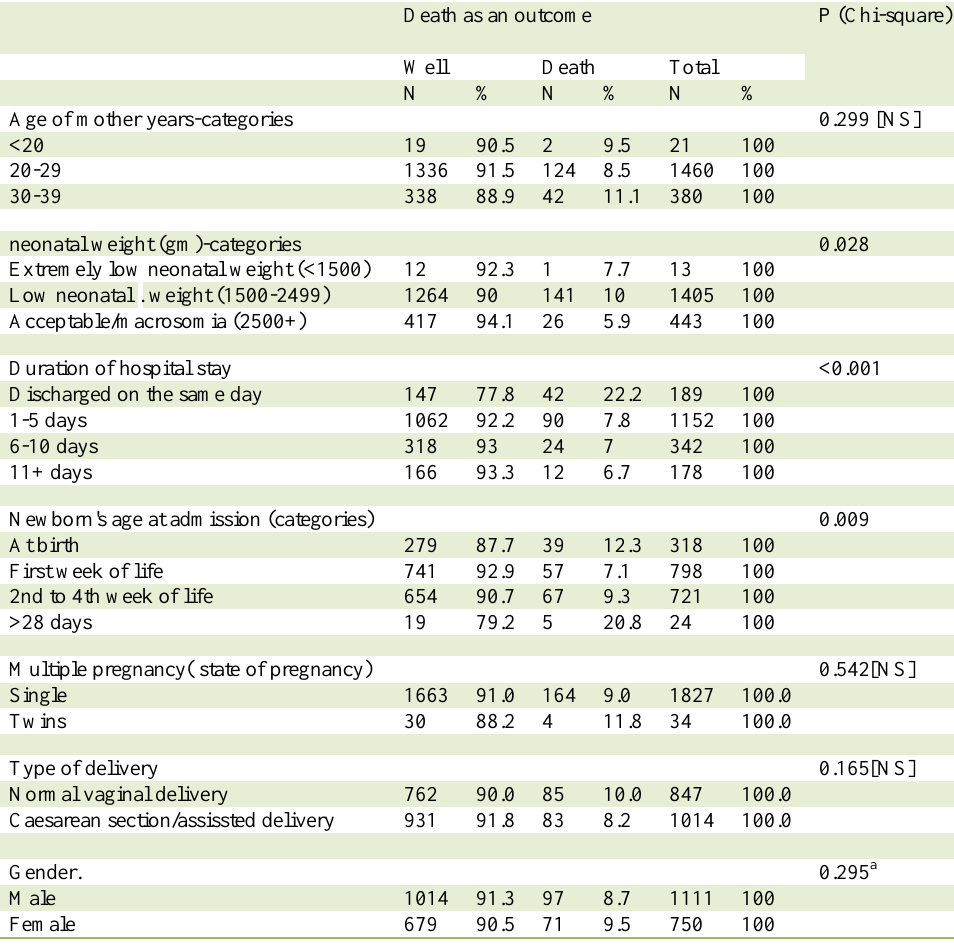
Table 6: The case fatality rate by selected explanatory variables Death as an outcome P